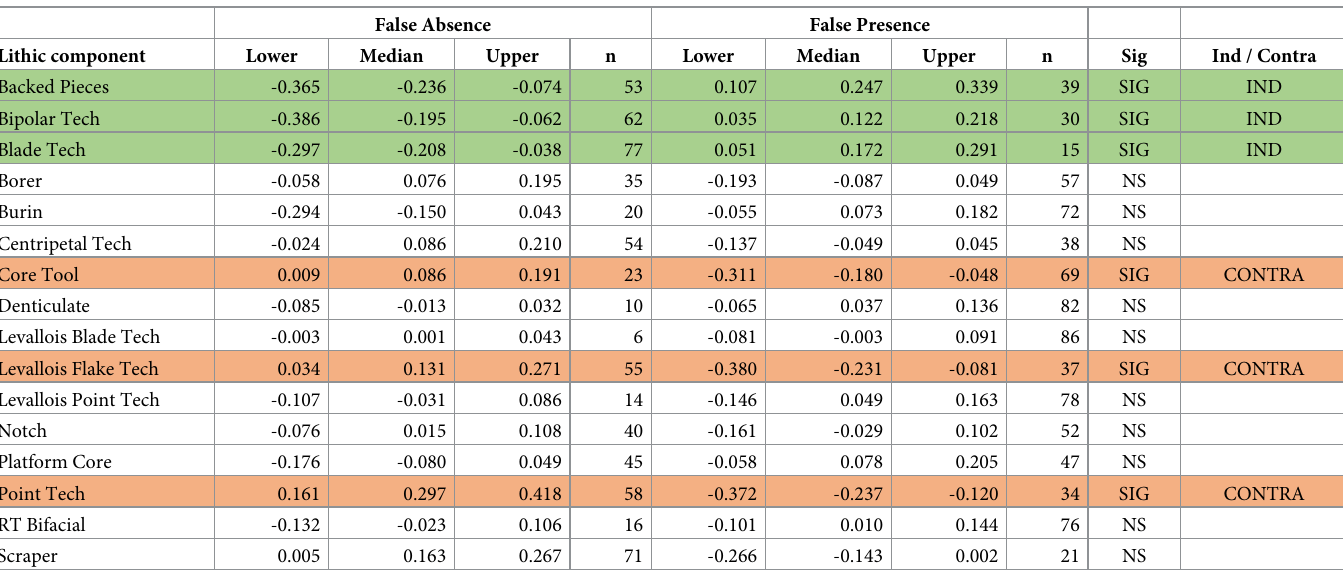
Table 4. Significant indicators of LSA assemblages in the 3-way analysis.